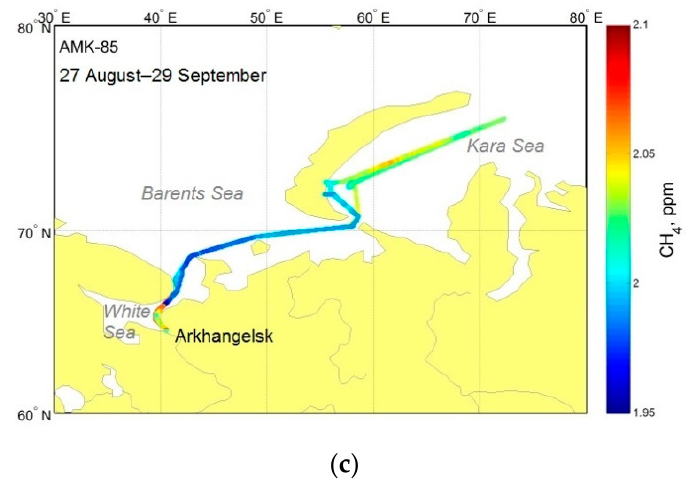
Figure 3. Variation in methane mole fraction in surface layer during the cruises of R/V Akademik Mstislav Keldys in summer and autumn of 2021 (AMK-83 ( a ), AMK-84 ( b ), and AMK-85 ( c )).